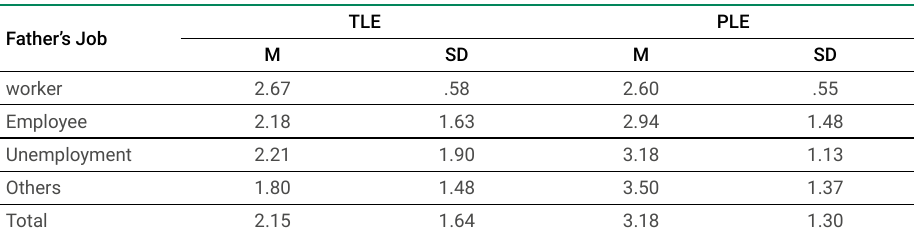
Table 7. The mean and standard deviation of the practice scores after intervention in terms of education type and father’s job. Father’s Job